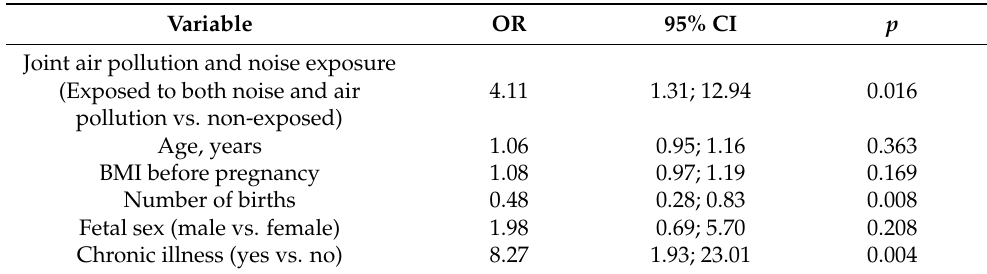
Table 2. Multivariate logistic regression for the prediction of preeclampsia by joint air pollution and noise